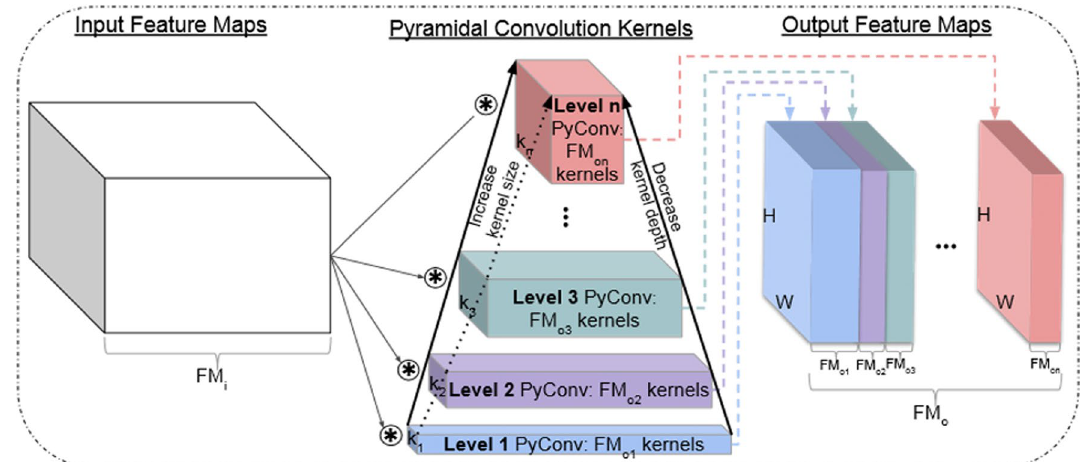
Fig. 4 The structure of PyConv